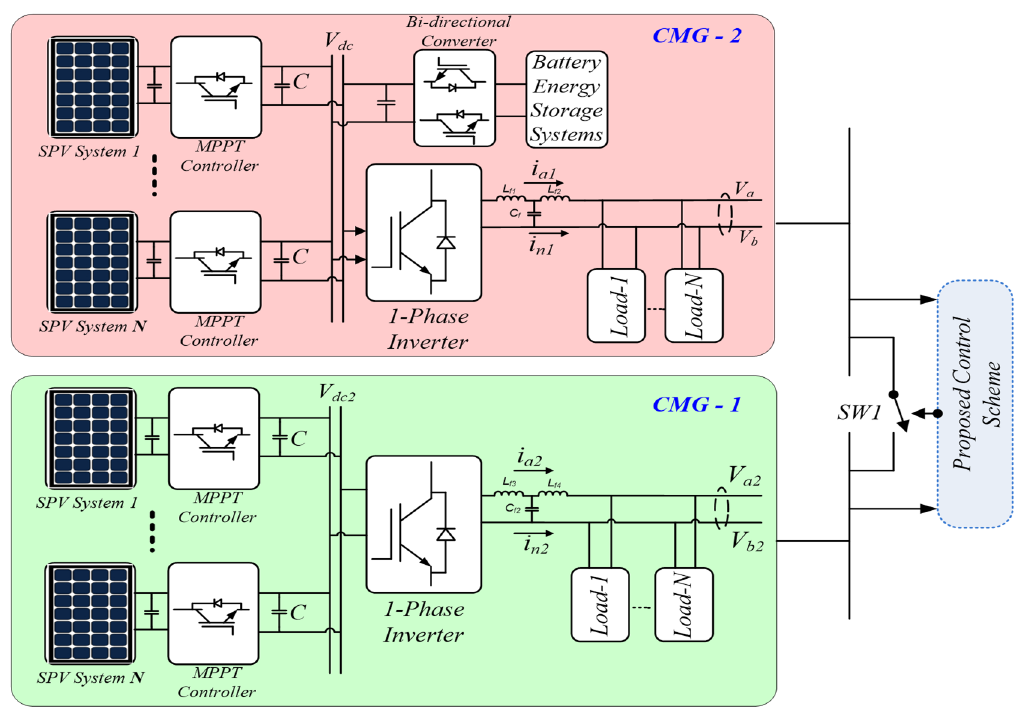
Figure 1. The overall architecture of the proposed system configuration.